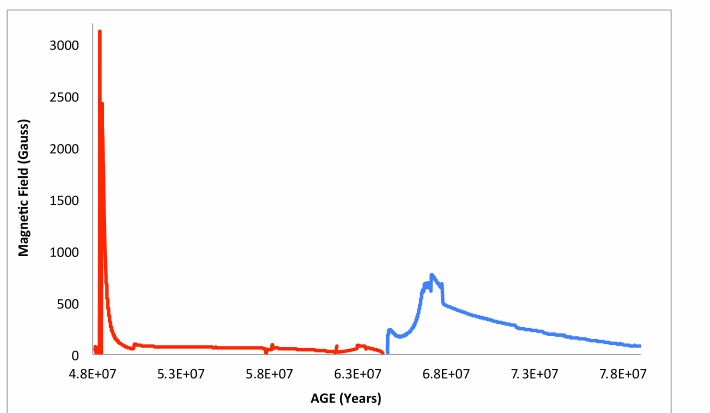
Figure 6. Evolution of the radial magnetic field strength (in Gauss) produced by the Spruit mechanism for the binary mentioned in Figure 5. (Case A: red; Case B: